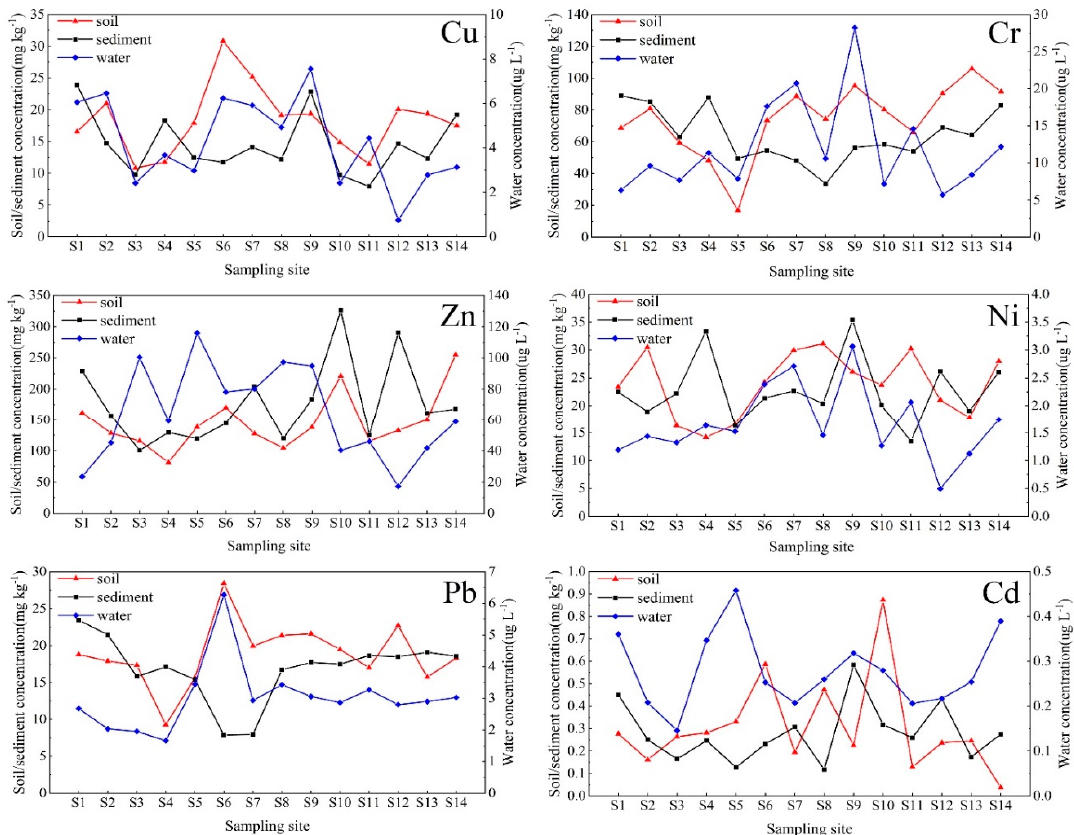
Figure 2. Concentration of Cu, Cr, Zn, Ni, Pb and Cd in the water, sediment and riparian soil.